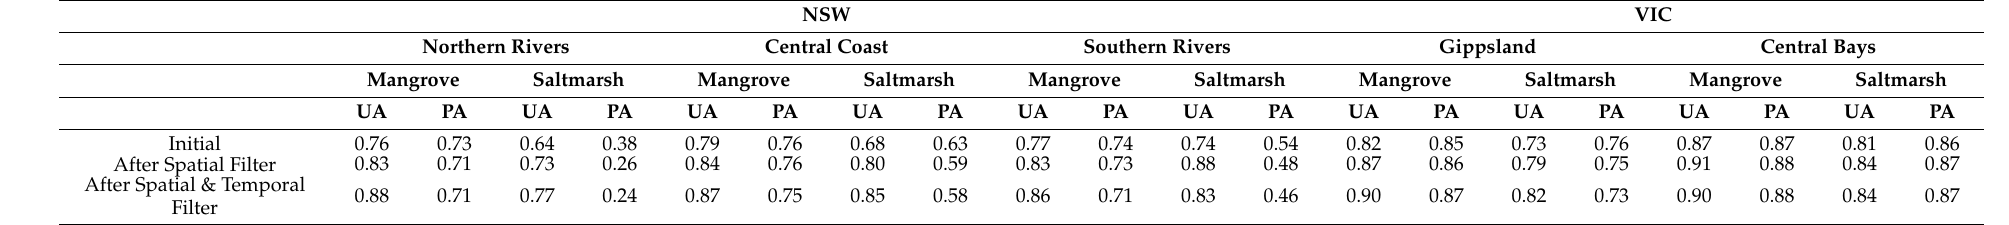
Table 5. User (UA) and Producer Accuracy (PA) for the classes of interest (Mangroves and Saltmarsh) across all regions for the 2006/Landsat 5 model before and after applying the classification